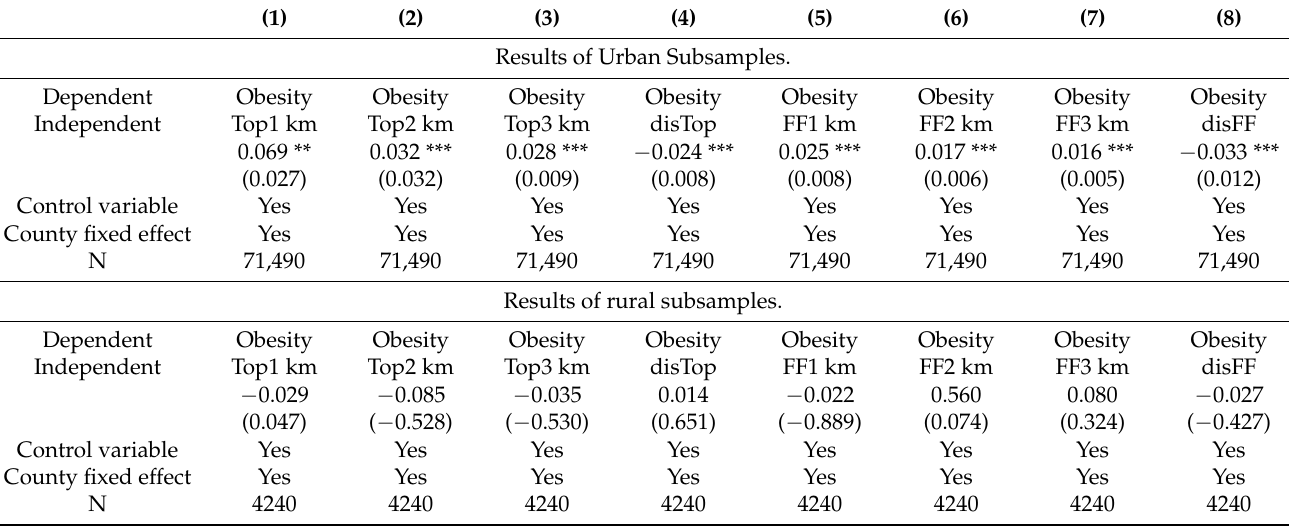
Table 6. Urban and rural subsamples.